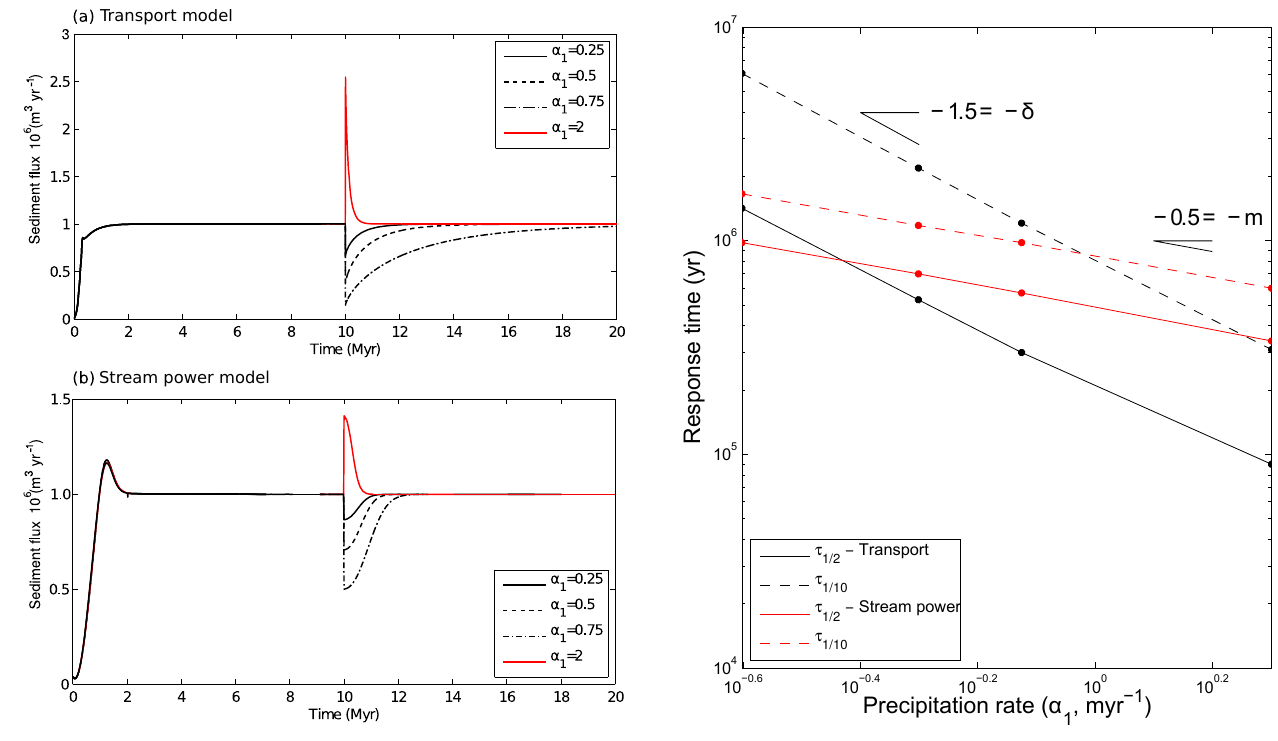
Figure 10. Log–log plot of response time to a change to a precip- itation rate of α 1 from an initial value of α 0 = 1myr − 1 when the model domain is 100 by 100km (see Table 2); τ 1 / 2 is the time for the sediment flux to recover by half of the magnitude change in sed- iment flux and τ 1 / 10 is the time for the sediment flux to recover by